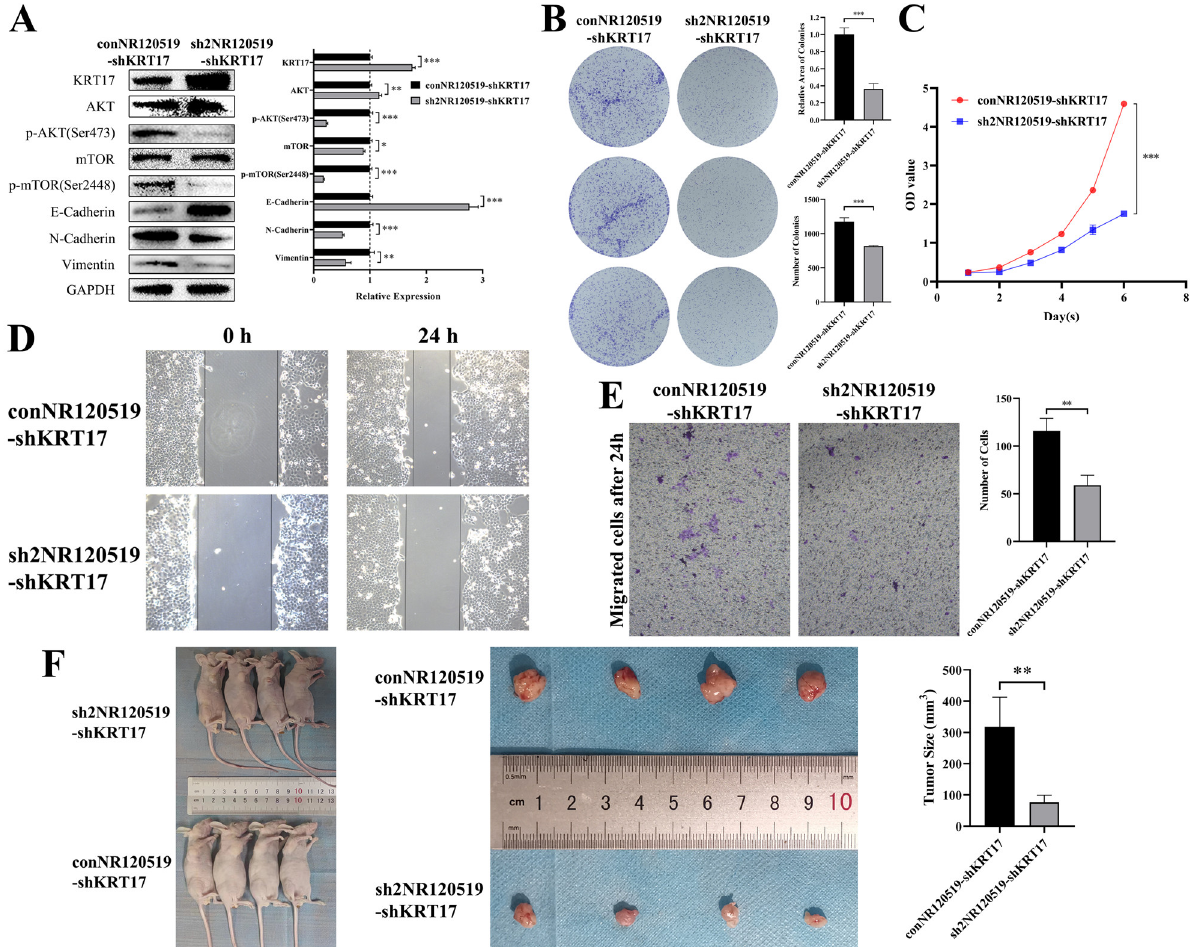
Figure 8. Knockdown of NR120519 reversed the effect of KRT17 silencing in Fadu cells. ( A ) western blotting showed that, the knockdown of NR120519 resulted in about 2 fold increase in KRT17 ex- pression, significant decrease in AKT and mTOR phosphorylation levels, upregulation of E-cadherin, downregulation of N-cadherin and VIM expression. ( B ) Colony formation assays showed that Fadu colonies were significantly reduced after knocking down NR120519. ( C ) CCK-8 assays demonstrated that knockdown of NR120519 retarded the proliferation of cells. ( D , E ) wound healing and Transwell experiments showed that knockdown of NR120519 significantly decreased the migratory ability of cells. ( F ) NR120519 knockdown exhibited a significantly reduced tumor size. * p < 0.05; ** p < 0.01; *** p < 0.001. The uncropped bolts are shown in Supplementary Materials File S1.